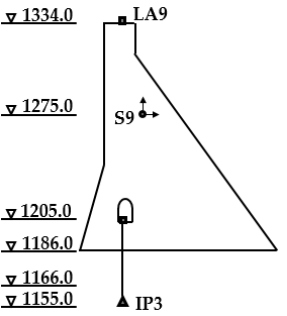
Figure 7. The layout of the monitoring project for 9# section of the dam. The monitoring points LA9 and IP3 are installed at the 1334 m elevation of the crest and 1205 m elevation of the dam foundation corridor of the 9# dam section, respectively, to monitor the displacement along and perpendicular to the river. LA9 is monitored by vacuum laser alignment (LA), and IP3 is monitored by inverted plumb lines (IP). Figure 8 depicts the working principle of the vacuum laser and inverted plumb line for dam deformation monitoring. LA systems are commonly used to monitor relative movement from the dam crest to the bank. The light spot at the receiving end changes with the movement of the zone plate on the measuring point. Therefore, the relative displacement of the measuring point can be calculated via the positional relationship among the transmitting end, the zone plate (measuring point), and the receiving end. At the same time, the absolute displacement of the vacuum laser measuring point can be obtained by superimposing the absolute displacement of the endpoint. IP systems are generally used to monitor relative movement from the dam’s rock foundation to the dam’s gallery level. The IPs include the floating ball group, the plumb line, and the anchoring point. The buoyancy of the floating ball keeps the vertical line in a vertical state. By regularly monitoring the movement of the floating ball, the displacement of the inspection gallery relative to the vertical line or the bottom of the borehole (assumed to be a fixed point of horizontal displacement) can be obtained. In addition, a stress sensor S9 was installed at the 1275 m elevation to measure the concrete stress of vertical and downstream direction in this area, which is the principal direction of interest for the stress monitoring of gravity dams. ( a ) ( b ) Figure 8. Instrument schematic of the dam deformation monitoring system (X-direction, Y-direc- tion represent the direction along the river and the direction perpendicular to the river, respec- tively). ( a ) Inverted plumb line, ( b ) Vacuum laser.